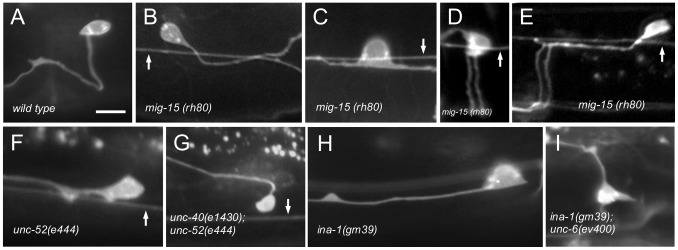
Mutations Affect the Direction of HSN Axon Protrusion.(A–G) Photomicrographs of L4 stage animals showing examples of the protrusion of the axon from the HSN cell body in wild-type and mutant animals. Ventral is down and anterior is to the left. Arrow indicates the PLM axon, if in the focal plane. Scale bar: 10 µm. (A) In wild-type animals, the HSN axon protrudes ventrally from the cell body. After reaching the ventral nerve chord the axon extends anteriorly and defasciculates from the cord to form synapses at the vulva. (B–E) In mig-15 mutants, the HSN axon can protrude posterior (B), anterior and posterior (C), ventral (D) or anterior (E). Most axons in mig-15 mutants that anteriorly or posteriorly protrude from the cell body eventually turn ventral. Only a few fail to reach the ventral nerve core (8% ±2, n = 100). (D–E) As axons cross the muscle/epidermis interface (see Figure 1B) they sometimes split into two parallel processes (26% ±1, n = 100). (F–I) As in mig-15 mutants, the axon protrudes anteriorly, posteriorly, or ventrally in unc-52, ina-1, unc-97, unc-112, and vab-19 mutants. In double mutants with either unc-40(e1430) (G) or unc-6(ev400) (I) the axon will sometimes protrude in the dorsal direction.